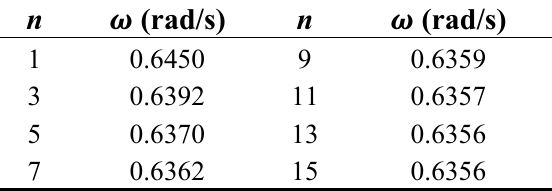
Table 1. Limit cycle frequencies for different values of n for Equation (34)